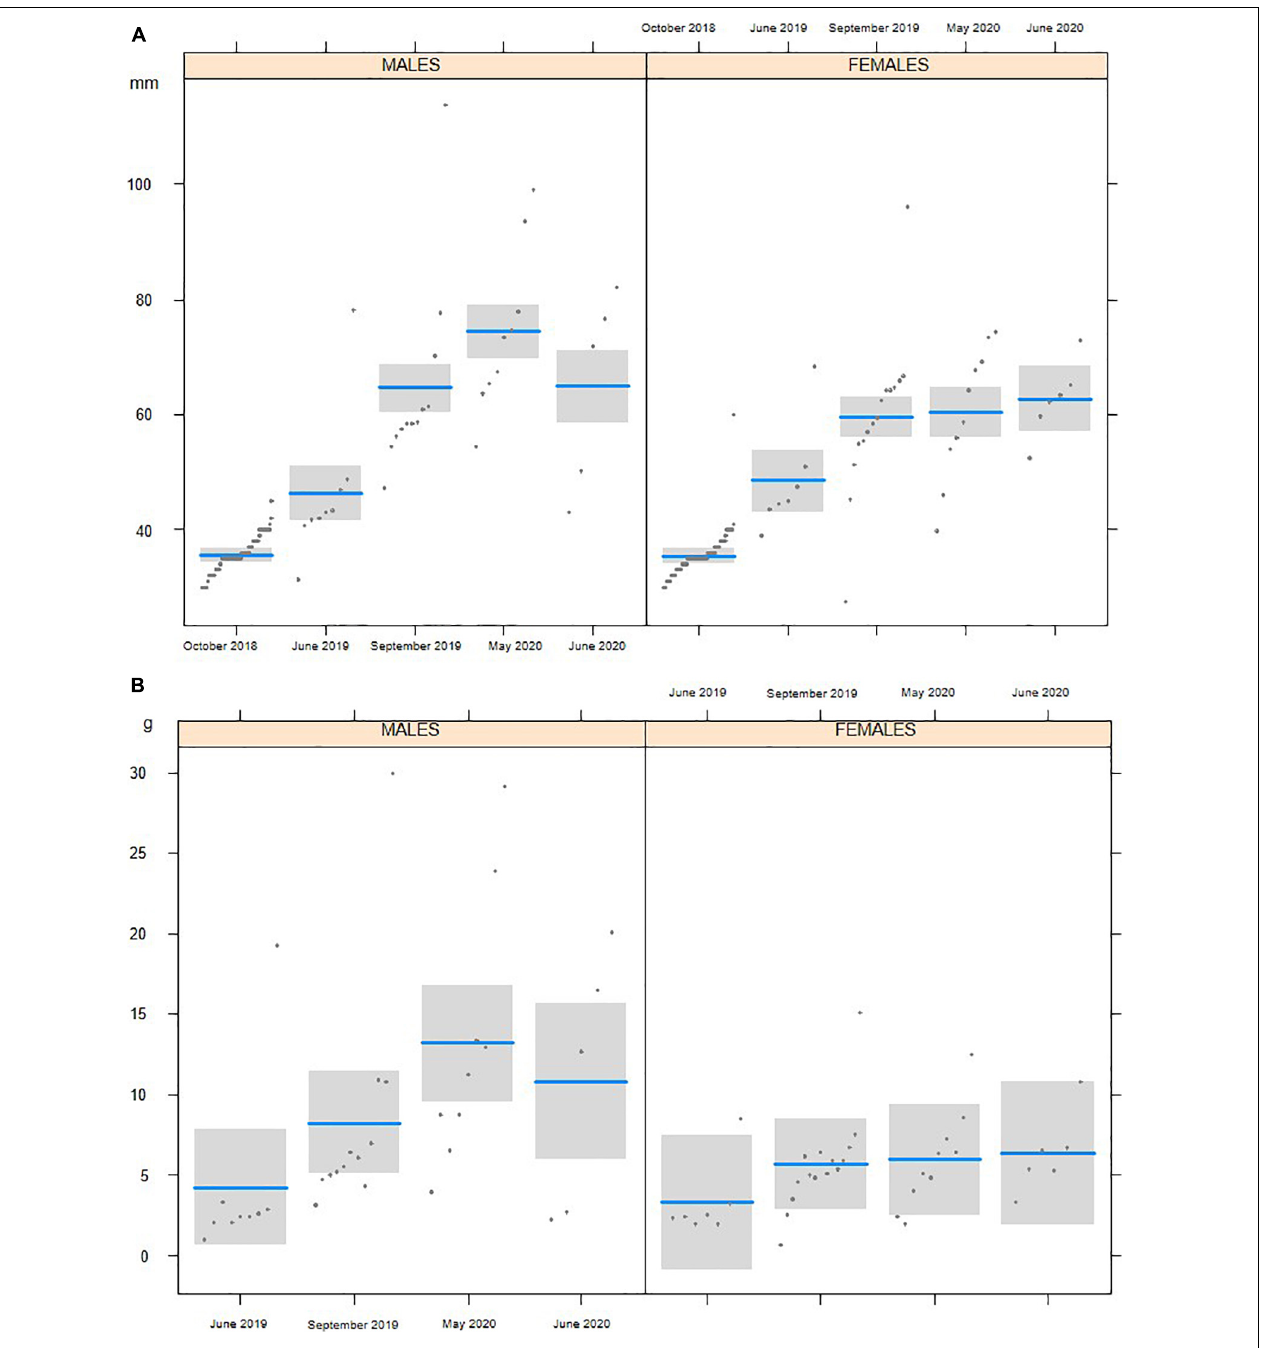
FIGURE 2 | Total length (A) and weight (B) of the individuals of Austropotamobius pallipes collected during the surveys performed from the first reintroduction in October 2018 to June